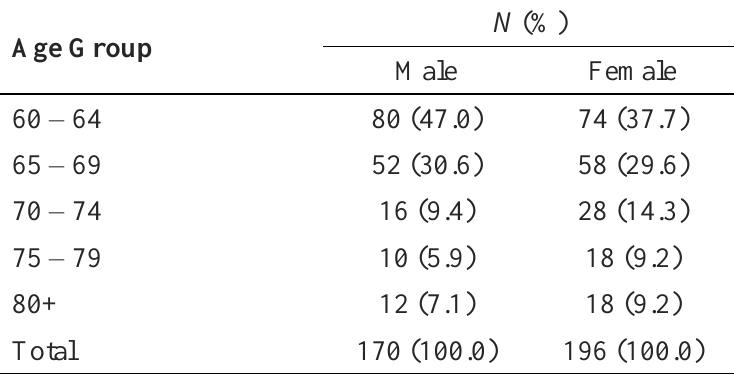
Table 1: Distribution of study population age and